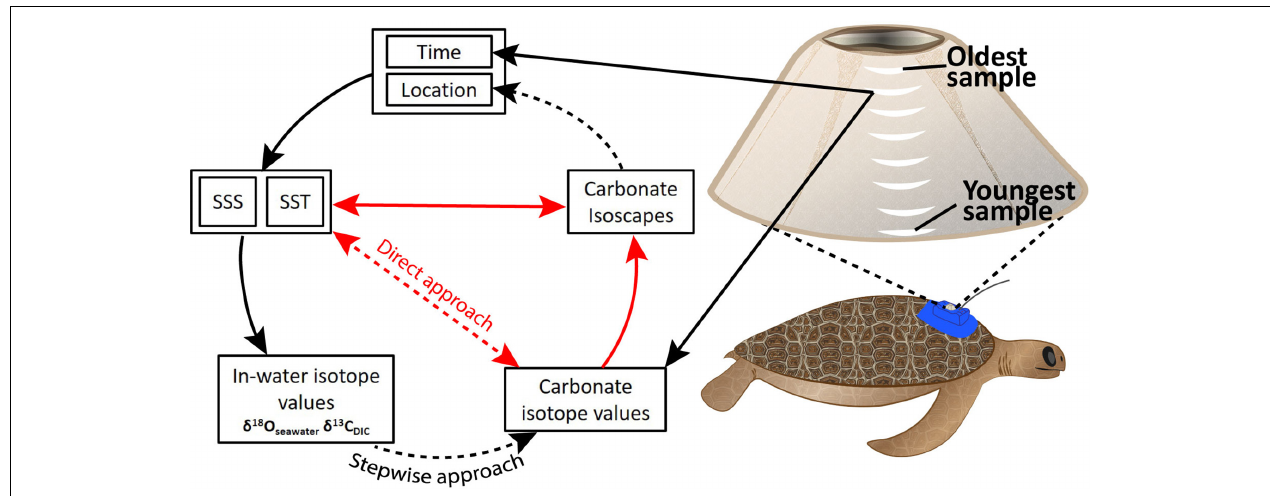
FIGURE 1 | Theoretical framework describing the relationships between time, location, salinity, temperature, and isotopes in seawater, dissolved inorganic carbon (DIC), and carbonate from barnacle shell. Direct physico-chemical relationships exist between SSS, SST, and δ 18 O/ δ 13 C isotope values for seawater and dissolved carbon (in-water isotope values). In-water isotope values affect carbonate isotope values in barnacle shell. These relationships informed the stepwise approach we explored. Our direct approach attempted to bypass need of knowledge around in-water isotope values by describing a direct relationship between SST, SSS, and carbonate isotope values. Black arrows indicate known relationships. Red arrows show mathematical relationships related to spatial ecology and paleoclimatology. Dashed arrows show relationships we were aiming to describe regionally in this study. SSS: sea surface salinity. SST, sea surface temperature. Carbonate isotope values refers to δ 18 O and δ 13 C values in barnacle